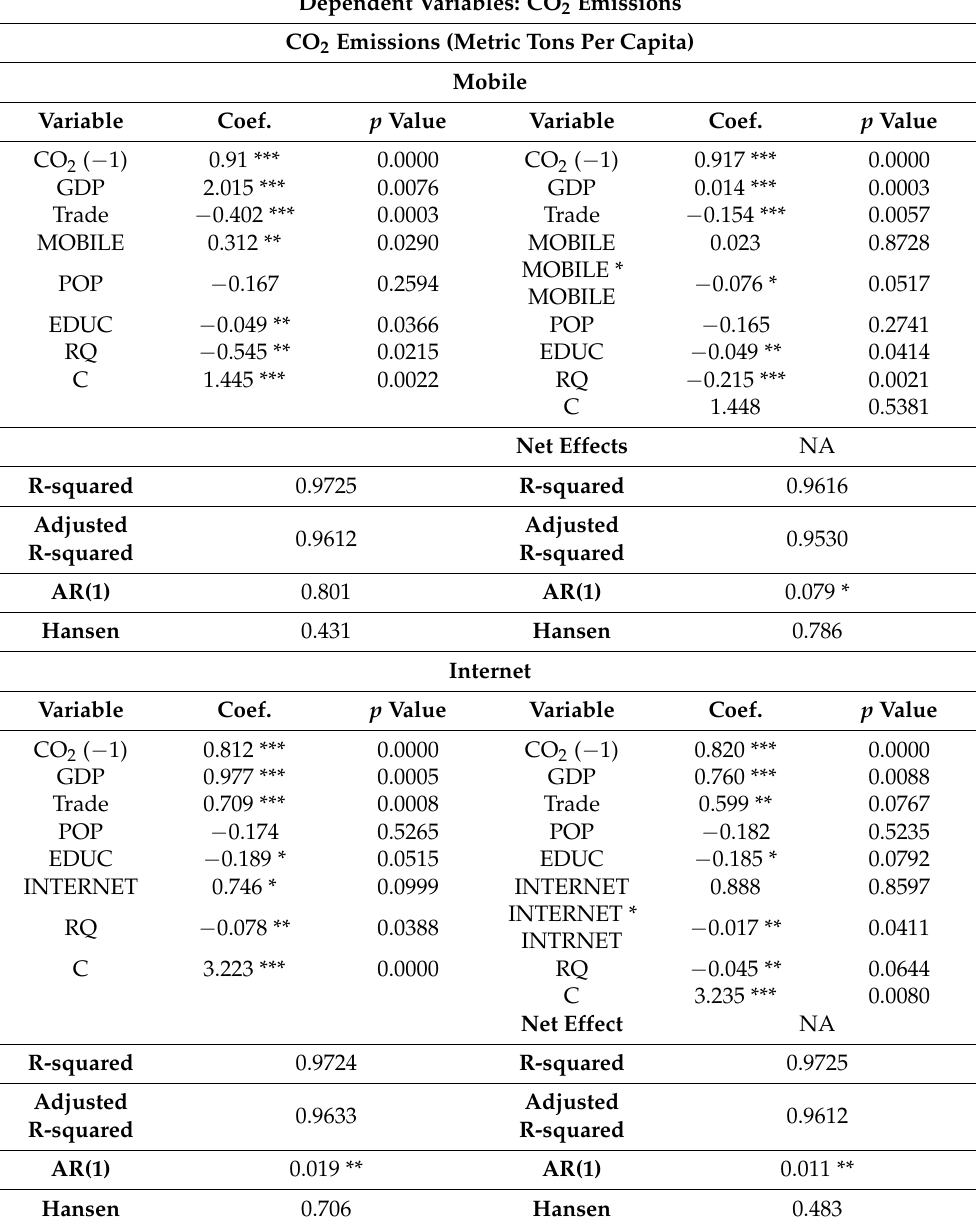
Table 4. Empirical